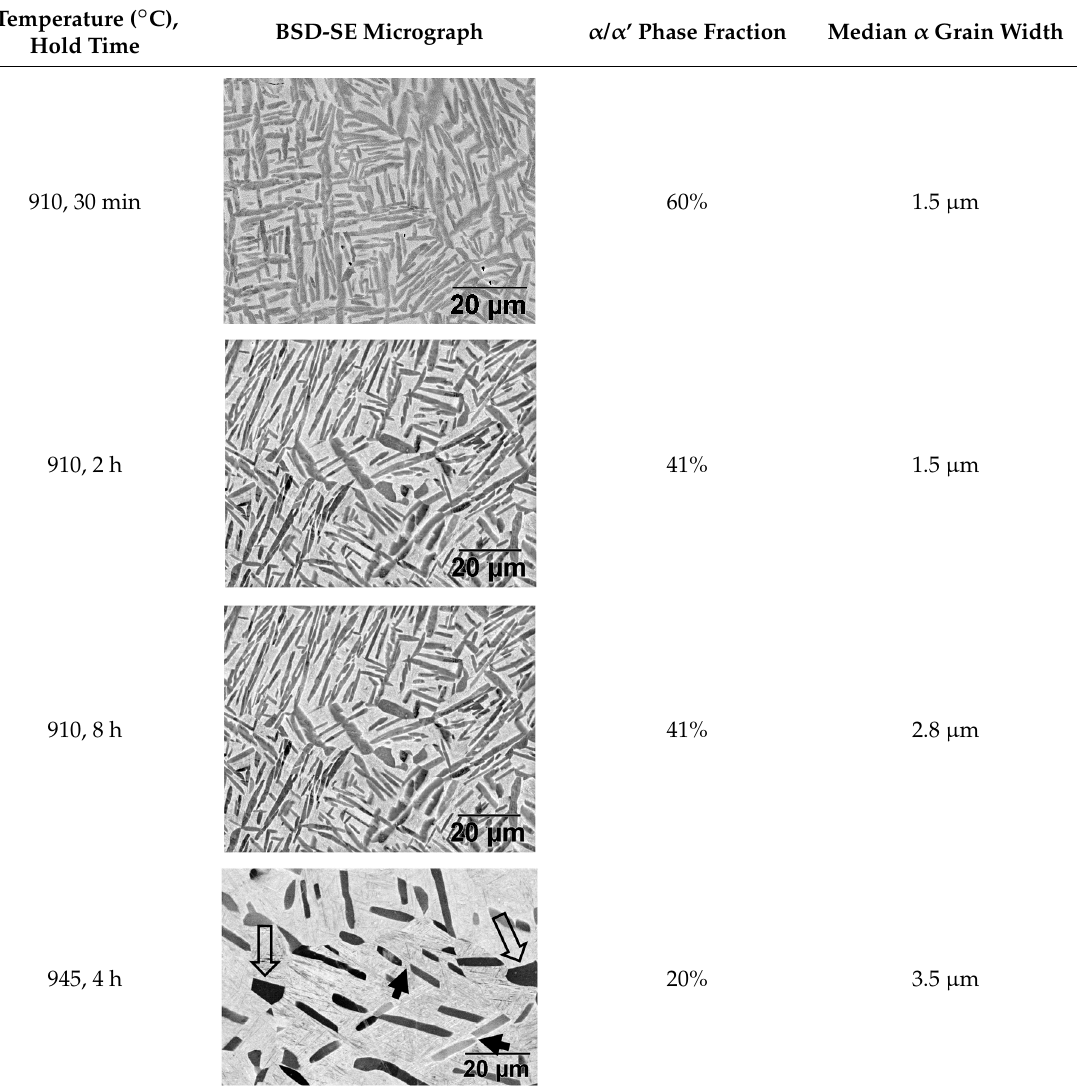
Table 6. Microstructure—annealing at 910 °C and 945 °C. Grain fragmentation and globularisation is indicated by solid and hollow arrows